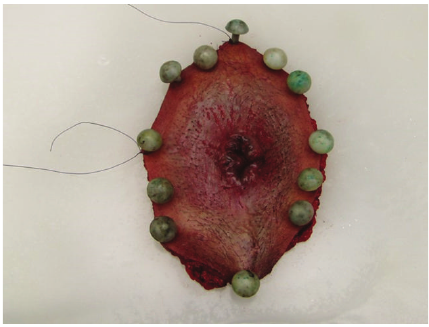
Figure 2: Wide local excision to include all positive biopsy sites was